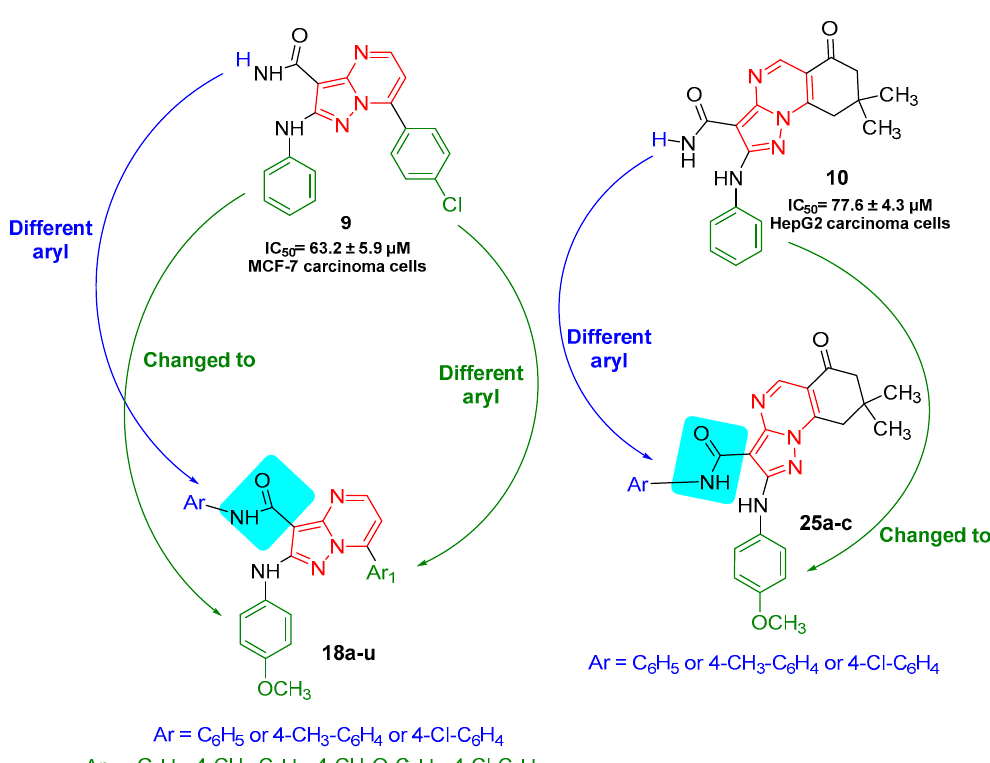
Figure 2. Design of novel N -aryl-pyrazolo[1,5- a ]pyrimidines 18a – u and N -aryl-pyrazolo[1,5- a ]quinazolines 25a – c -based amide linkages.